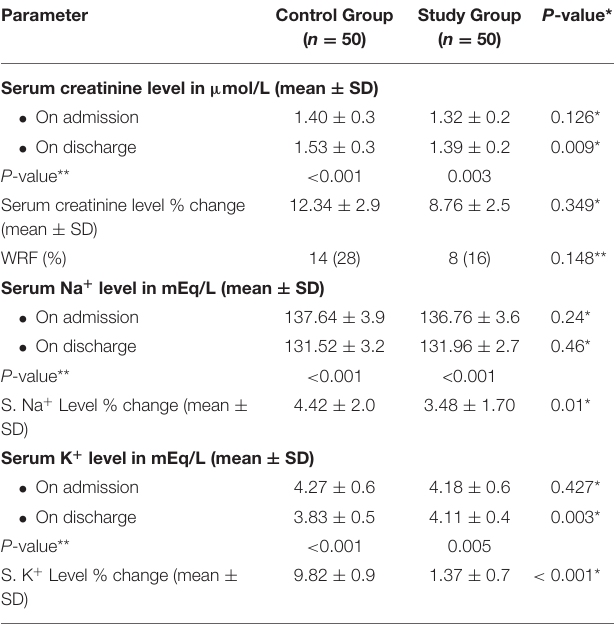
TABLE 4 | Change in renal function and serum electrolytes of the studied population. Parameter Control Group